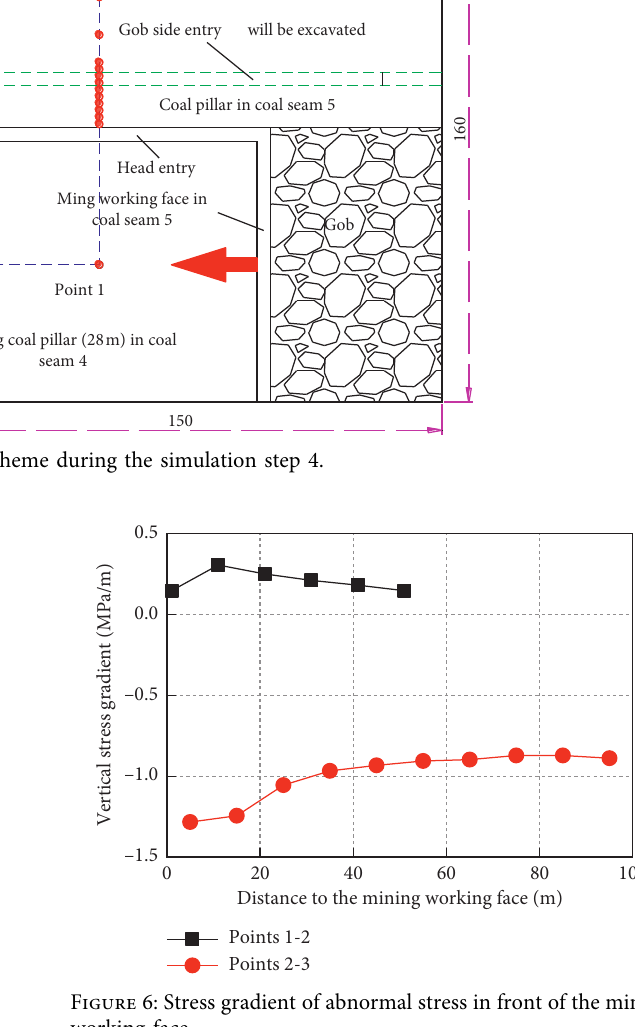
Figure 5: Concentration coefficient of abnormal stress in front of the mining working face.